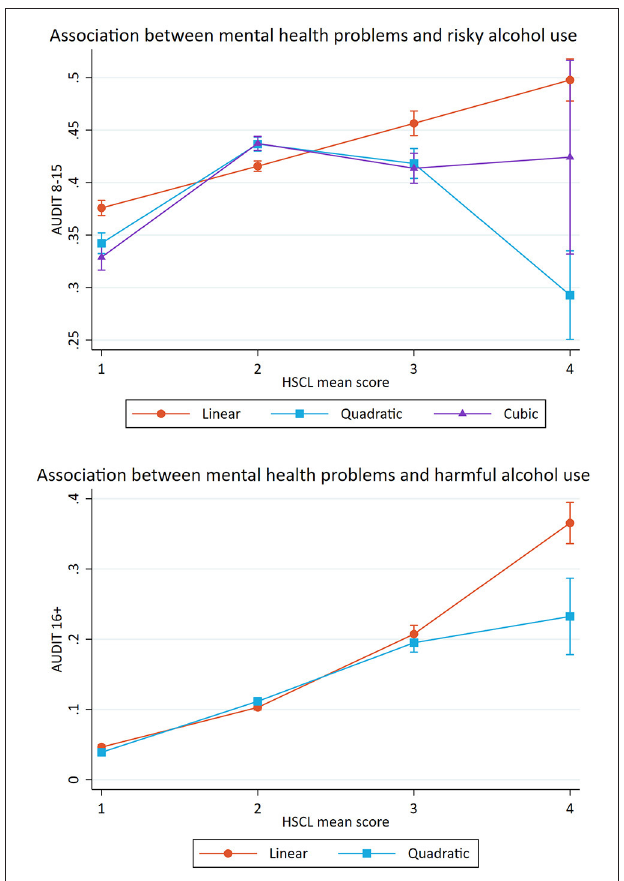
FIGURE 2 | Association between mental health problems and potential alcohol-related problems. Predicted probabilities of alcohol-related problems (The Alcohol Use Disorders Identification test; AUDIT) across mean scores on Hopkins Symptom Checklist (HSCL). Error bars represent 95% confidence intervals.